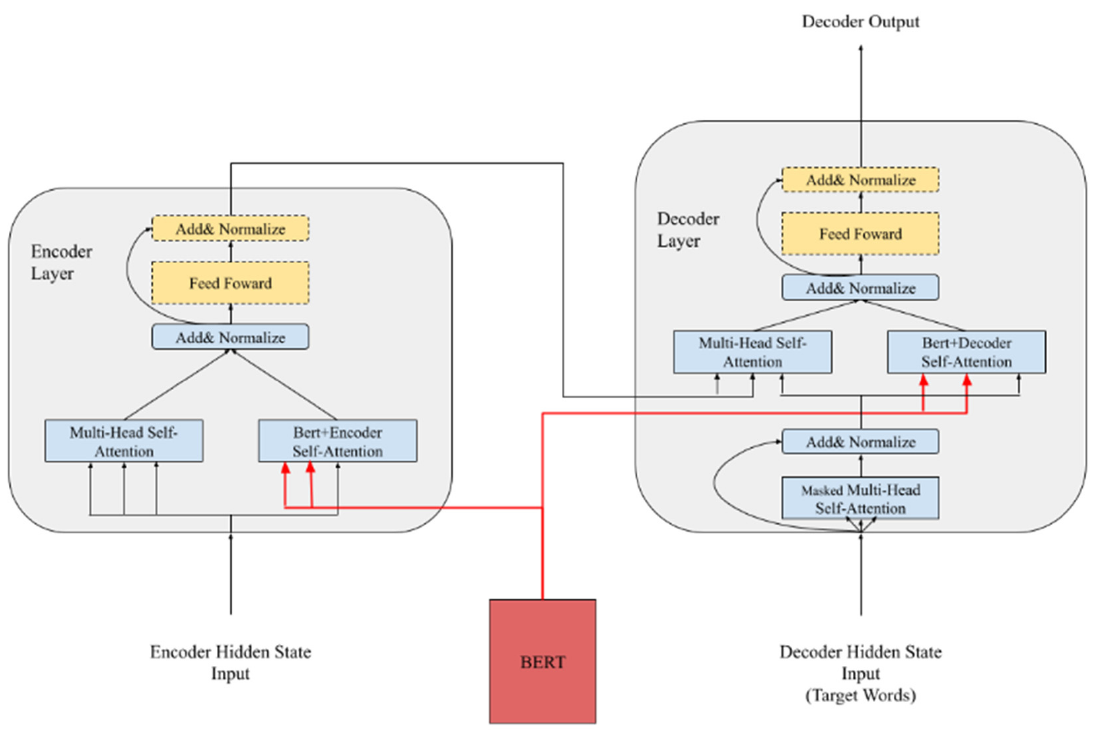
Figure 1. The structure of the model combining BERT with the transformer.